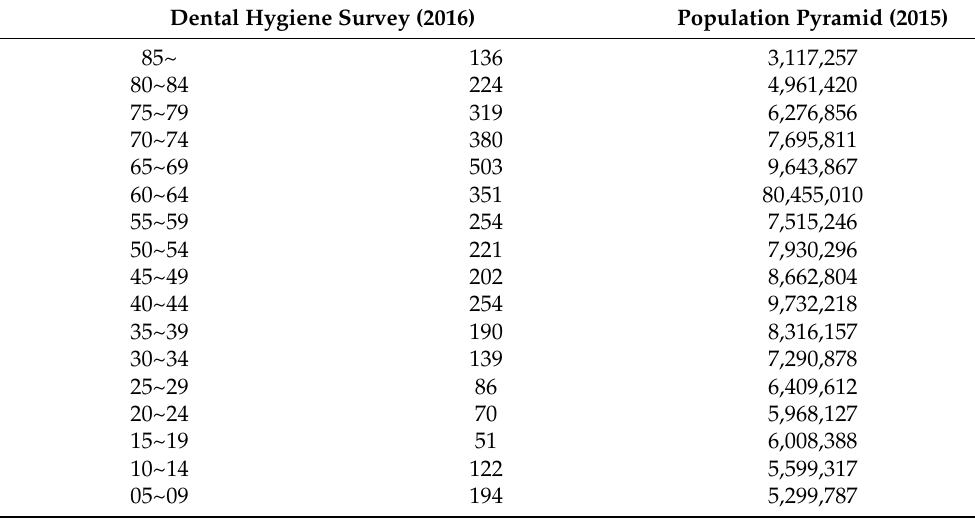
Table 2. Age distribution of the sample of the Dental Hygiene Survey vs.